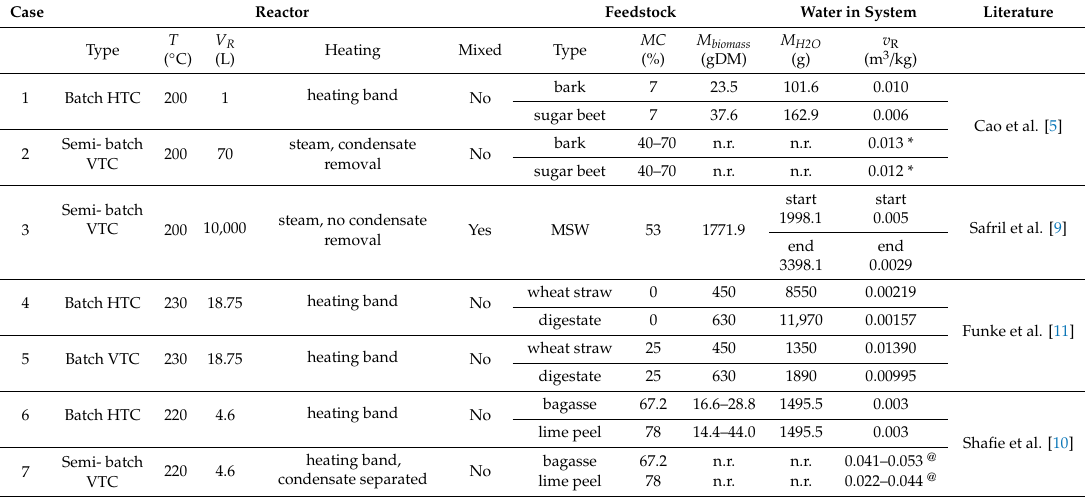
Table 2. Overview of the process conditions and feedstock for the seven cases with VTC / HTC processes. Case Reactor Feedstock Water in